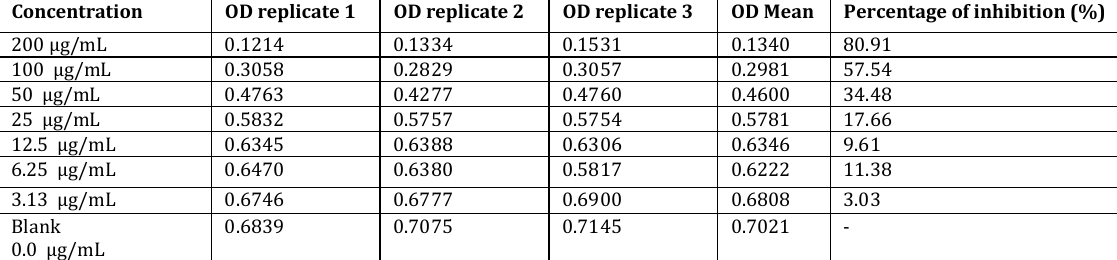
Table 1: Percentage of oxidation inhibition for young leaves